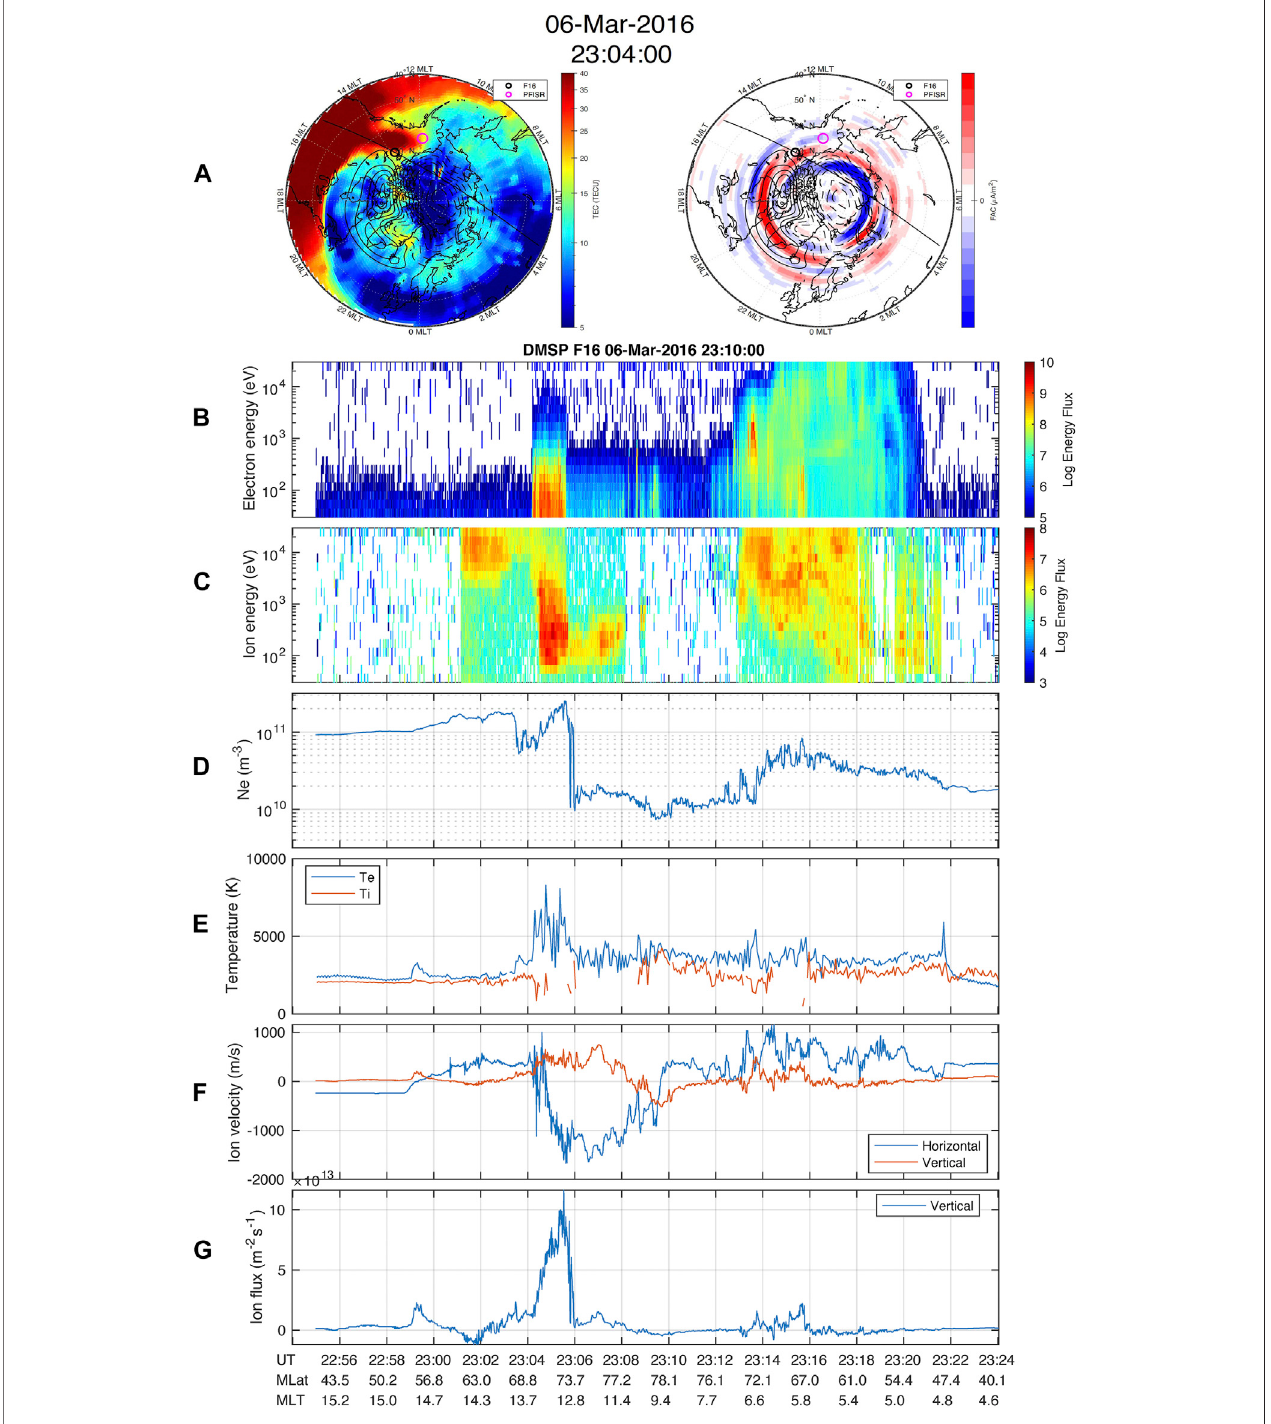
FIGURE 10 | The same format as Figure 9 but the large up fl ow fl uxes were associated with the fully grown SED plume.